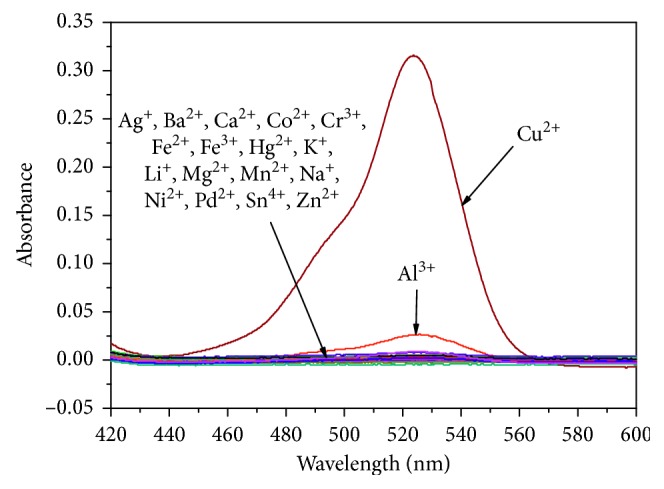
Absorbance spectra of L1 (10 μM) with addition of 10 μM various metal ions in CH3CN/H2O solution (1 : 1, v/v).